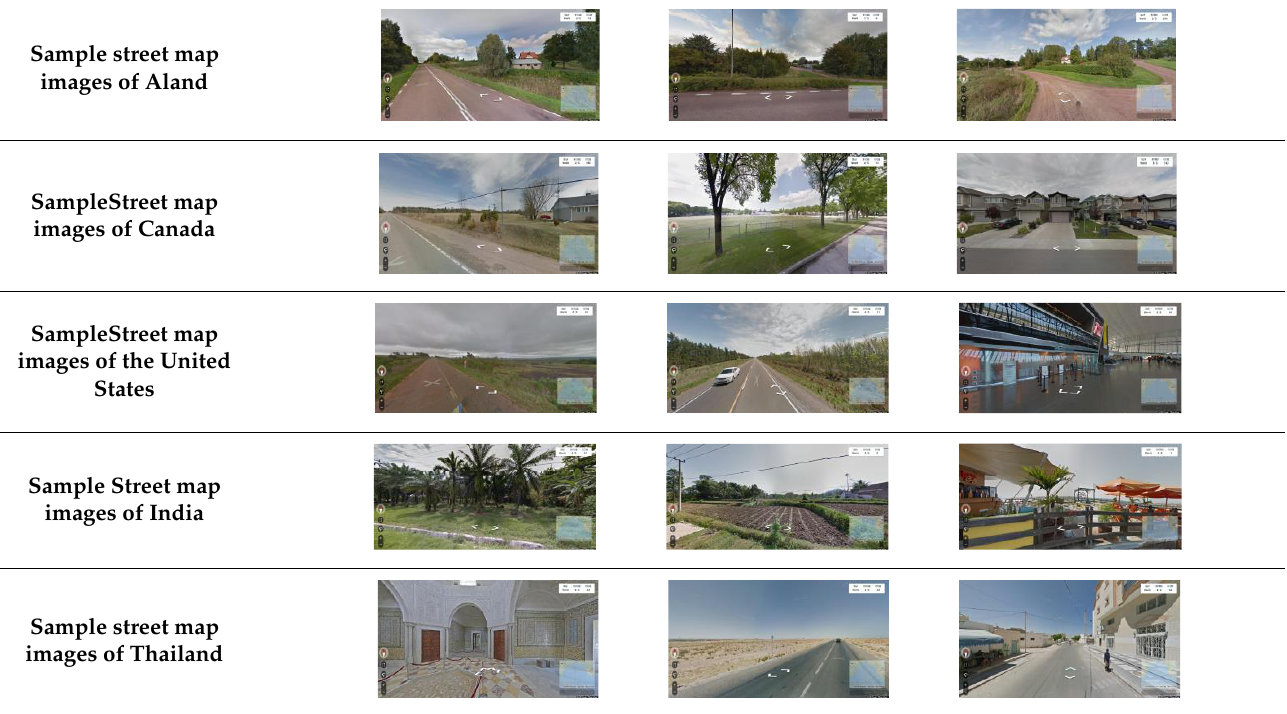
Table 3. Samples of the